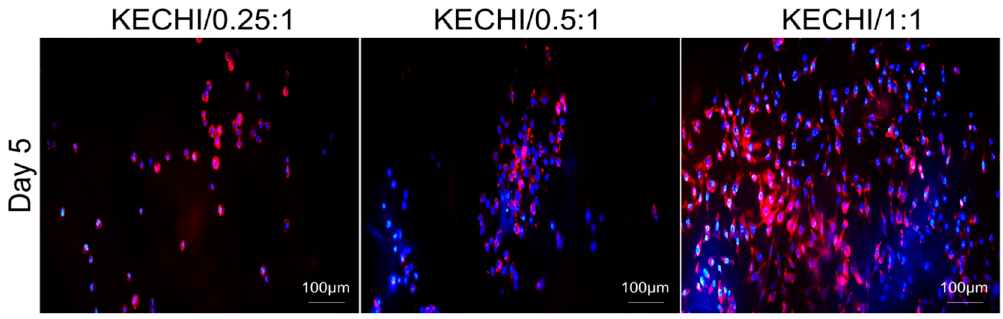
Figure 6. Immunofluorescence staining of L929 cells seeded on keratin-chitosan membranes. Confocal microscopy images of L929 stained with phalloidin for F-actin (red), and nuclei counterstained with DAPI (blue) in all keratin-chitosan membranes at day 5.